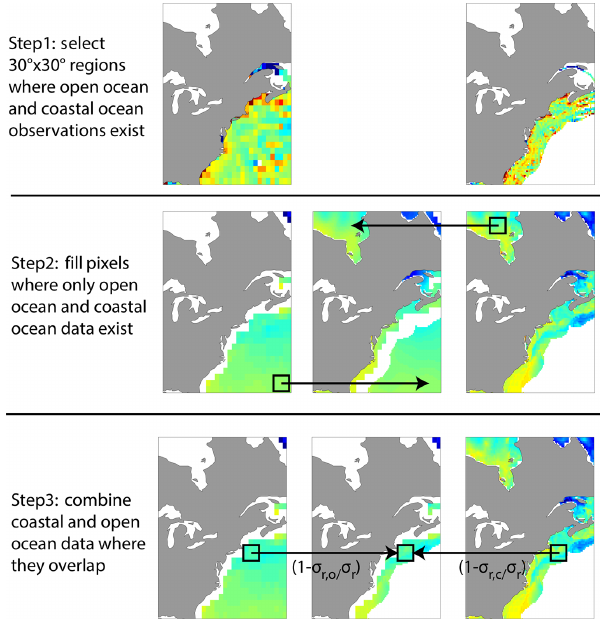
Figure 4. Box-and-whisker plot of the mean difference (a) , stan- dard deviation (b) and number of 0.25 ◦ pixels occupied with mea- surements (c) in the common overlap area for each 30 ◦ × 30 ◦ box used for merging NN open and NN coast